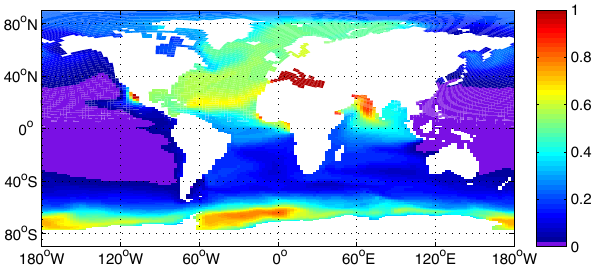
Fig. 13. Mean (1978–2007) simulated surface iron concentration in nmoll − 1